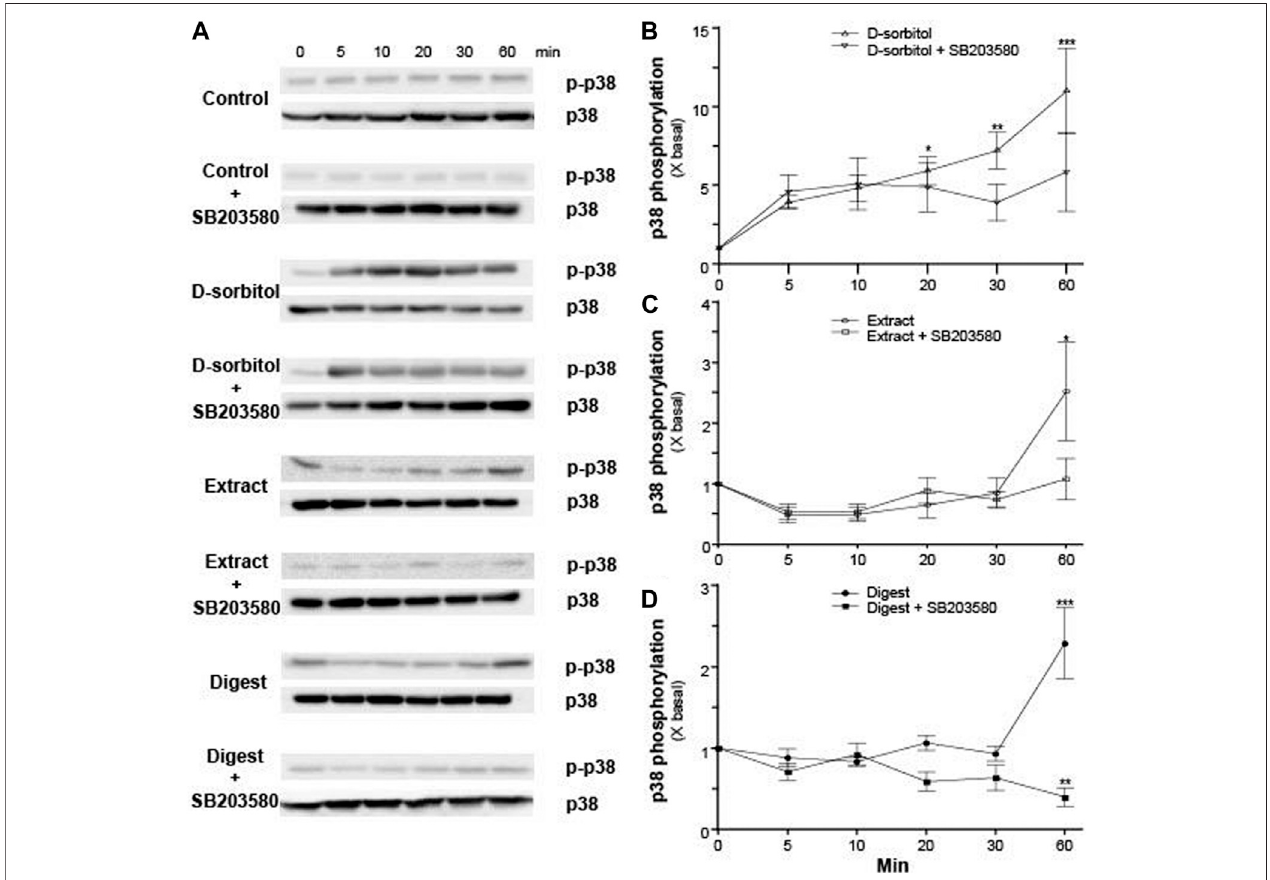
FIGURE 5 | The p38 MAPK inhibitor blocks EBN-induced p38-MAPK phosphorylation. (A) After 16-h serum starvation, cultured differentiated keratinocytes were pre-incubatedwithorwithoutSB203580(ap38kinaseinhibitor;10 μ M)for2 h,followedbydifferenttimesofappliedD-sorbitol(apositivecontrol,400 mM),EBNextract or digest (both at 100 μ g/mL). Total p38-MAPK (p38-MAPK) and phosphorylated p38-MAPK (p-p38 MAPK) (both at ∼ 38 kDa) were evaluated by western blot assays. The quanti fi cations of p-p38 MAPK/p38 MAPK expression levels after different time of applied (B) D-sorbitol, (C) EBN extract, and (D) EBN digest with or without SB203580 pretreatment areshown. Values areexpressed inmean ± SEM, n (cid:2) 3.Statisticallysigni fi cantresultsaremarkedwith* p < 0.05,** p < 0.01, and *** p < 0.001 against the control.